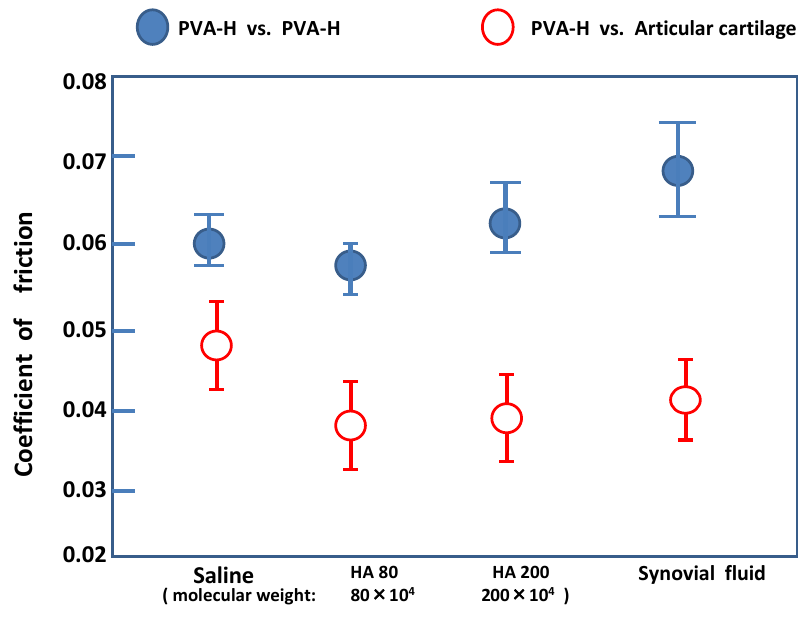
Figure 6. The influence of hyaluronic acid on the frictional coefficient of two combination of articular cartilage vs. PVA-H and articular cartilage vs. articular